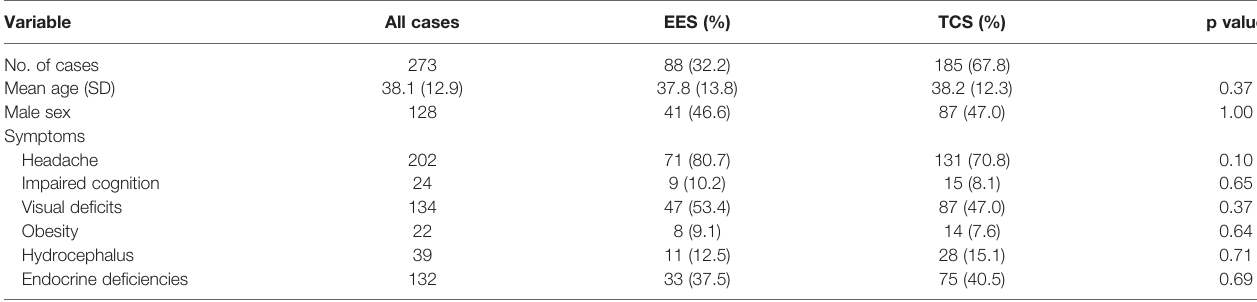
TABLE 1 | Main clinical manifestations of all the patients. Variable All cases EES (%) TCS (%) p value